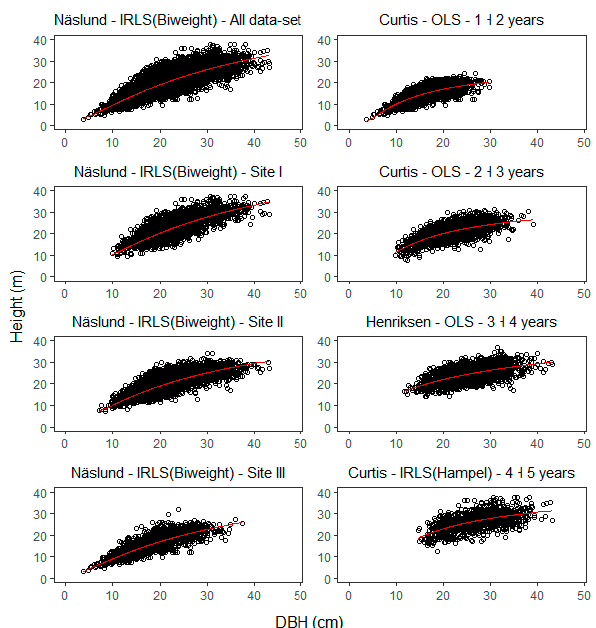
Figure 5. Predicted curves for the most representative model by classes of site-index and age for Ochroma pyramidale (balsa-tree) stands in Ecuador.